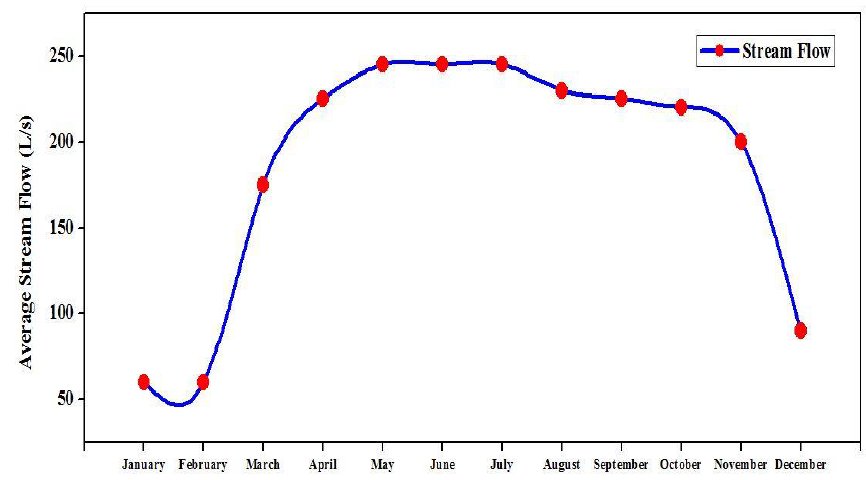
Figure 6. Monthly average stream flow of Dikrong River [54].